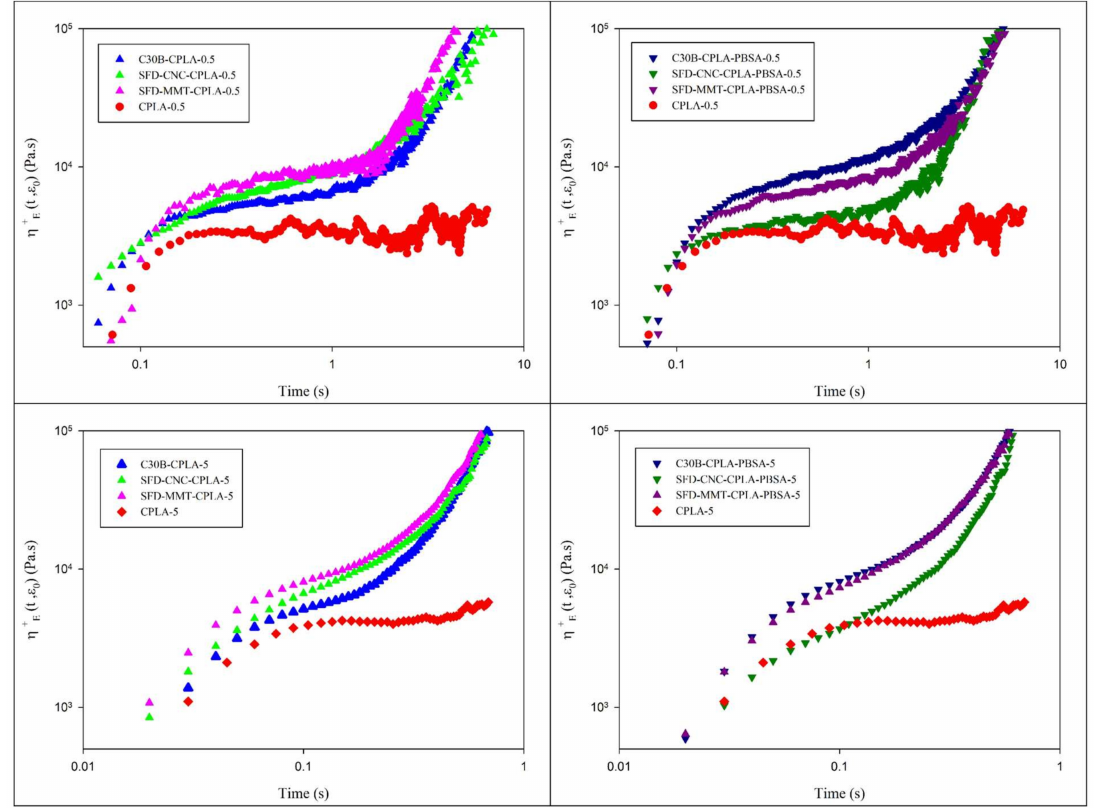
Figure 8. Elongational viscosity of the CPLA nanocomposites ( left ) and CPLA-PBSA ternary nanocomposites ( right ) at different Hencky strain rate of 0.5 s − 1 and 5 s − 1